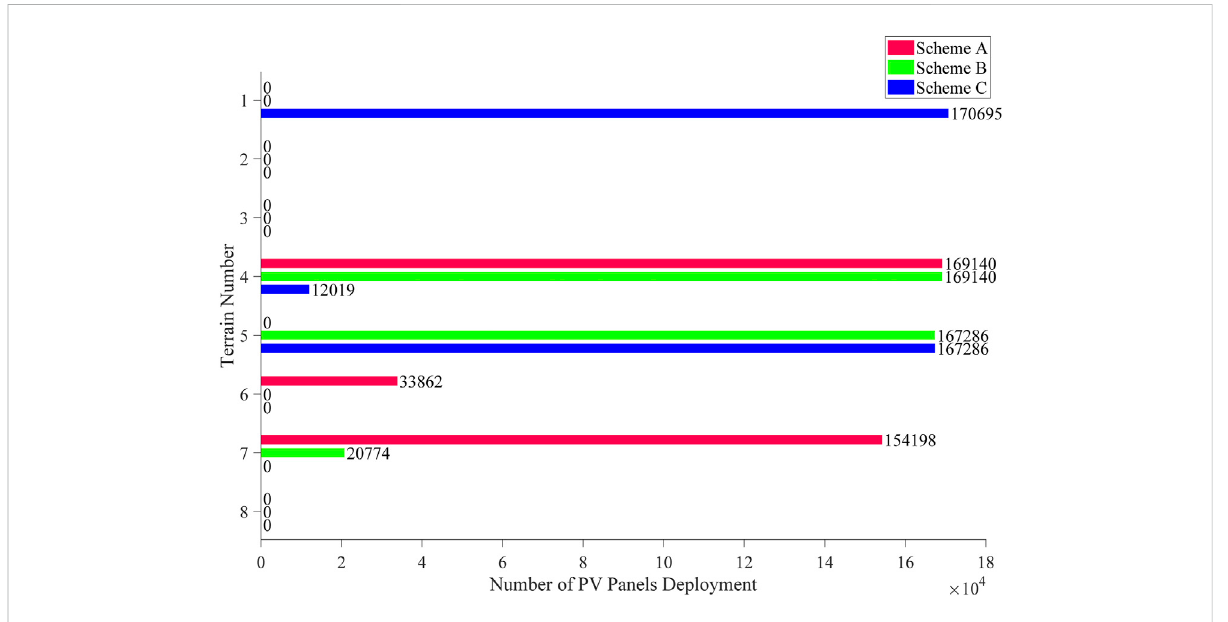
FIGURE 6 The deployment results of three different methods.